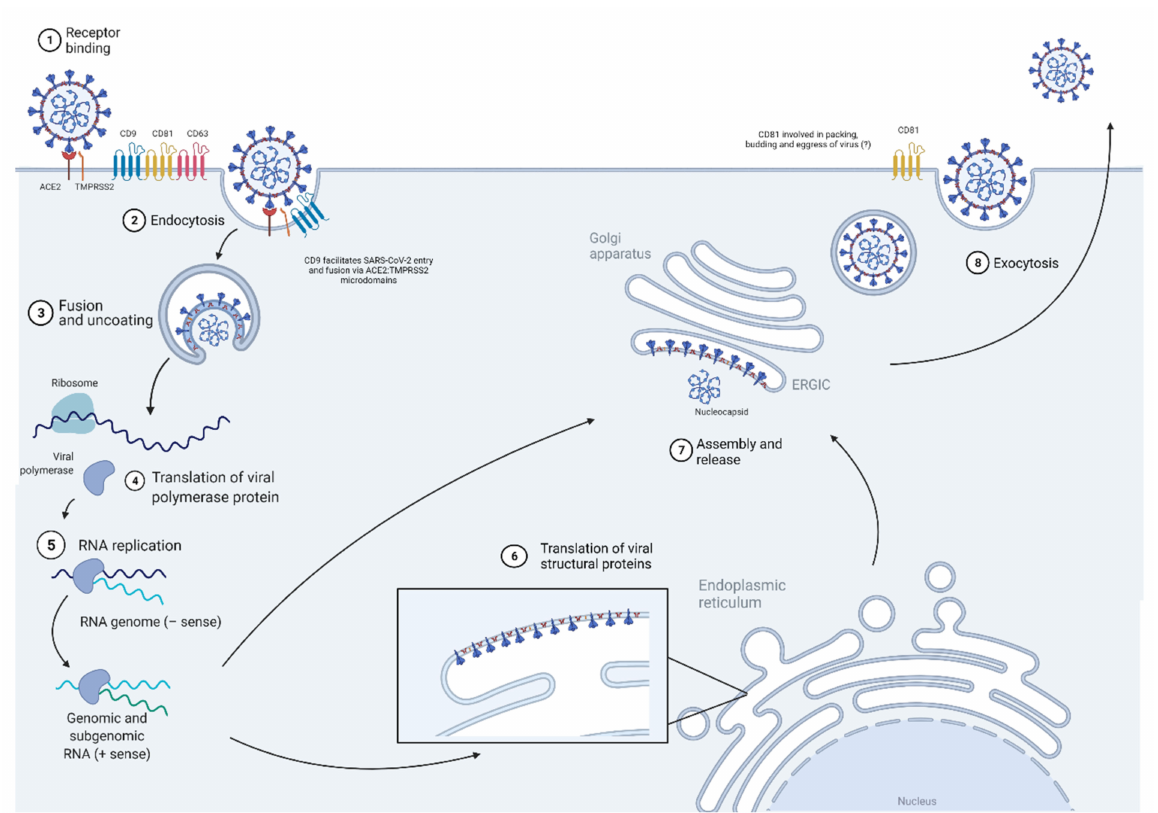
Figure 5. Diagram showing the contribution of tetraspanins in the SARS-CoV-2 replication cycle. CoV uses tetraspanin microdomains that are enriched with CD9, CD81, and CD63 for its entry and fusion. CD9 mediates the interactions between protease TMPRSS2 and CoV receptors, which are DDP4 in MERS-CoV and ACE2 in SARS-CoV-2. Abbreviations: CoV, coronavirus; ACE2, angiotensin-converting enzyme 2 receptor; TMPRSS2, transmembrane protease serine 2; CD9, cluster of differentiation; CD63, cluster of differentiation 63; CD81, cluster of differentiation